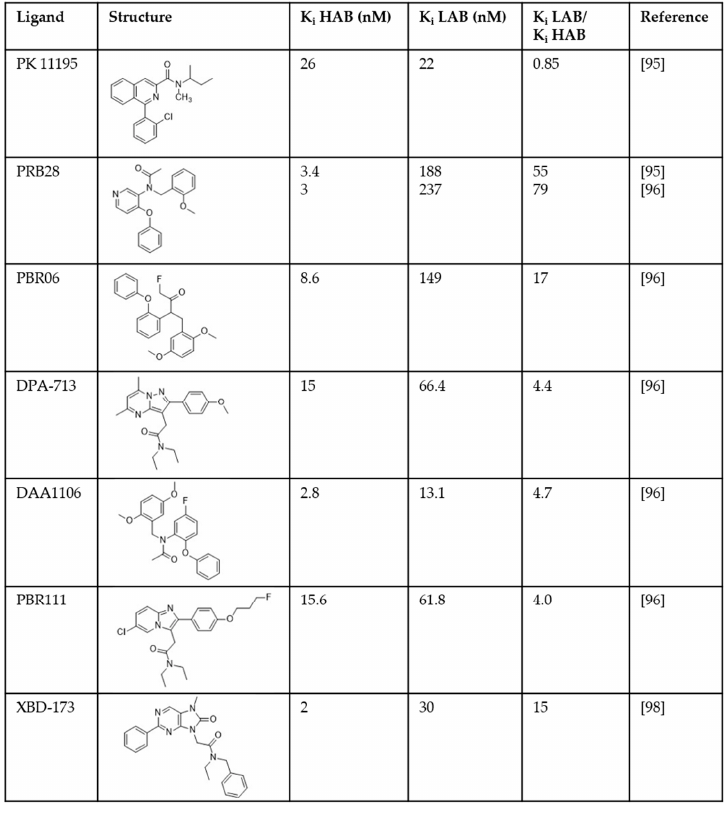
Figure 1. Distribution of affinities of translocator protein (TSPO) ligands measured in homogenates prepared from post-mortem human brain tissue. HAB = high affinity binders; LAB = low affinity binders [95,96,98].